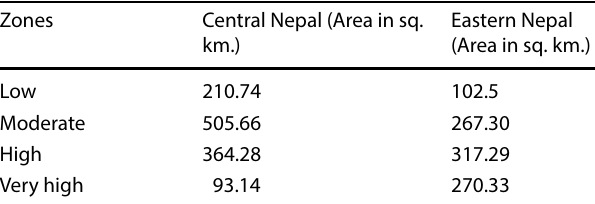
Table 7 Area under various zones of Damage Proxy map in Central Nepal and Eastern Nepal Zones Central Nepal (Area in sq.